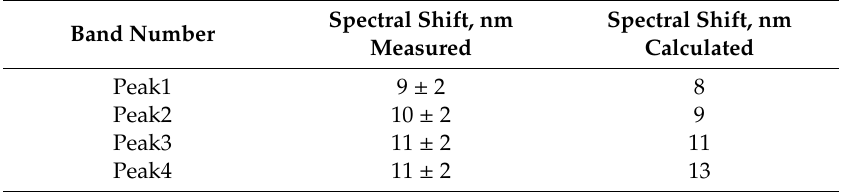
Table 1. Spectral shift of local transmission bands for MOW samples modified by PSS/PDDA layers. Spectral Shift, nm Spectral Shift, nm Band Number Measured